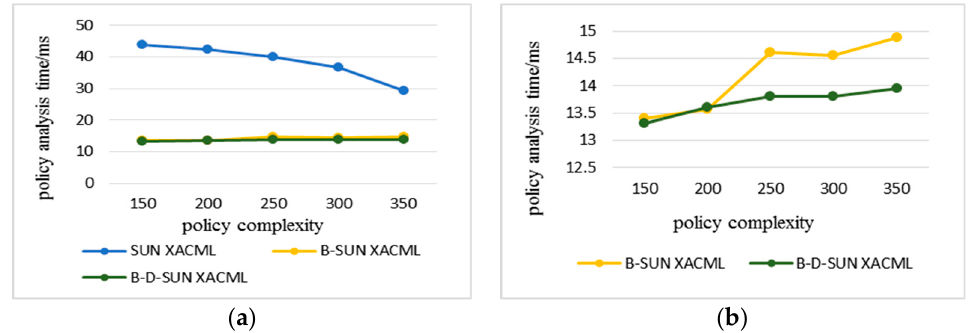
Figure 7. The policy analysis time varies with the increasing complexity of the policy. (a) Comparison of B-Sun XACML and B-D-Sun XACML with Sun XACML; (b) Detailed comparison between B-Sun XACML and B-D-Sun XACML.